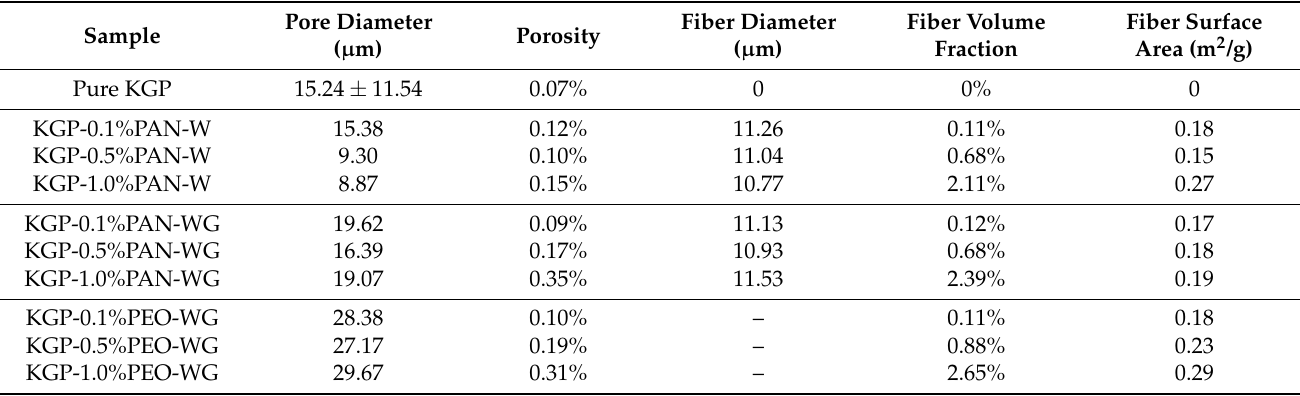
Table 3. Micro-CT Image Analysis Results of Polyacrylonitrile (PAN) and Poly(ethylene oxide) (PEO) electrospun fibers inside geopolymer